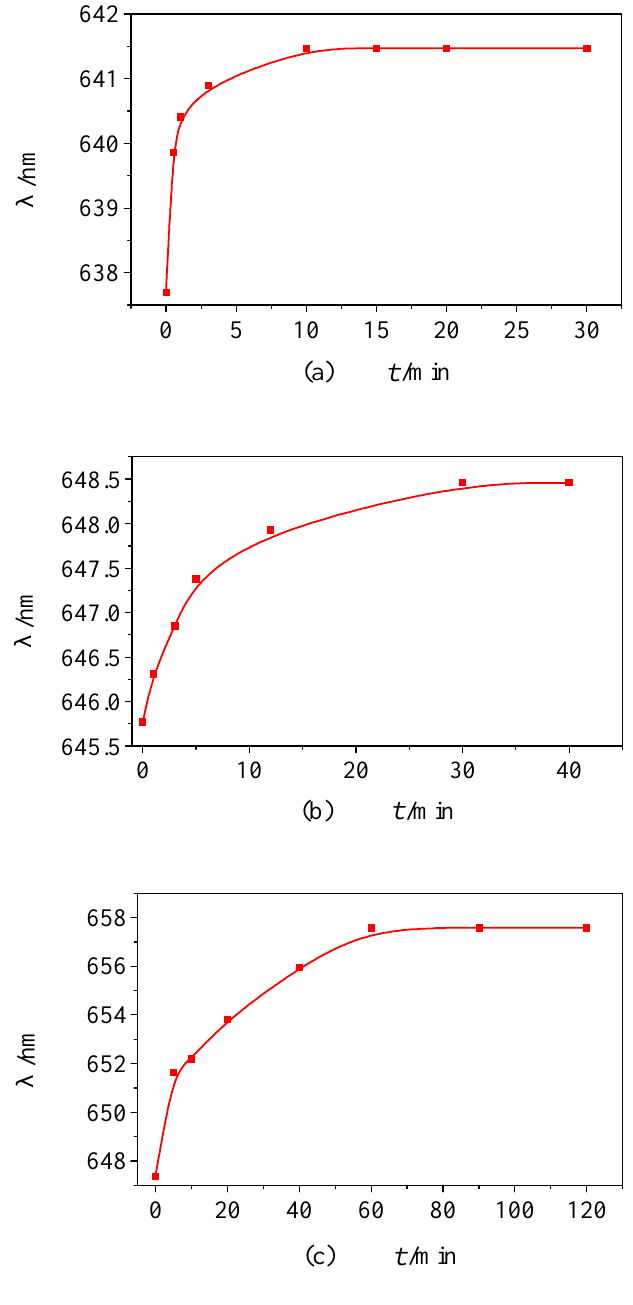
Figure 2. Resonant wavelength shift as a function of time for binding on the sensor surface. (a) avidin, Avidin concentration:0.2 mg/mL; (b) biotinylated anti-rabbit IgG, biotinylated anti- rabbit IgG titer: 1:20; (c) rabbit anti-human Bf